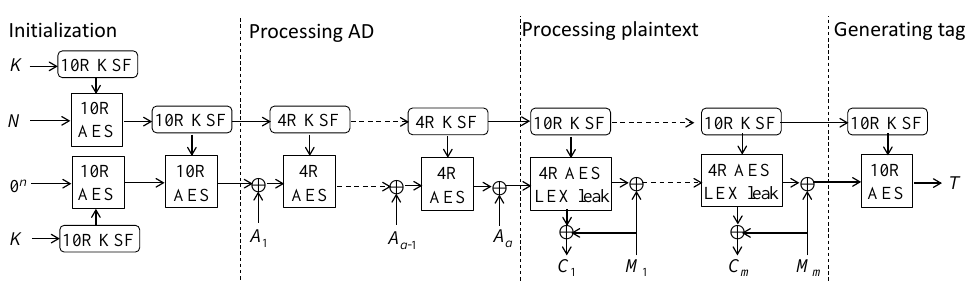
Figure 1: Encryption of ALE. N is a nonce, K is a secret key, A i is an i -th associated data blocks, M i /C i is an i -th plaintext/ciphertext block, and T is a tag. i R KSF/AES iterates the AES key-schedule/round function i times. 4R AES LEX leak iterates the AES round function 4 times and leaks 32 bits of a 128-bit output of each round to encrypt a plaintext